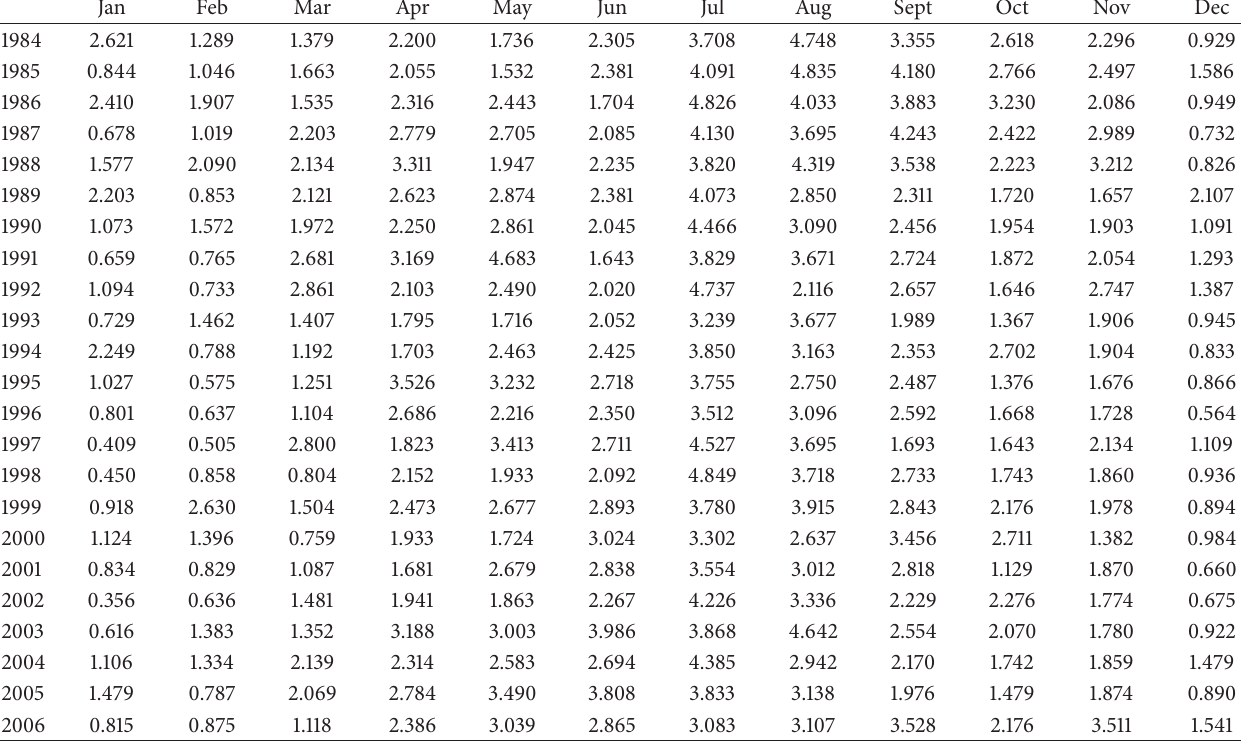
Table 2: FS statistics for global solar radiation.